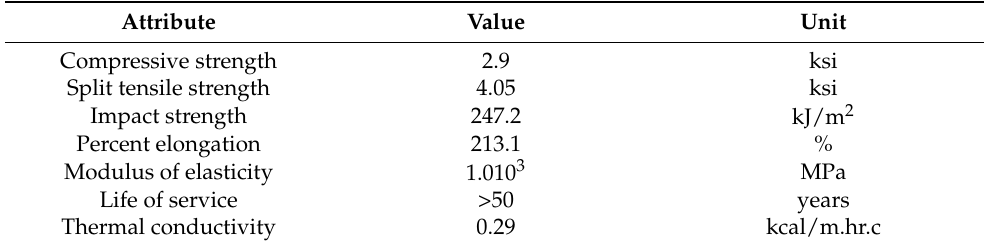
Table 1. High-density polyethylene (HDPE)